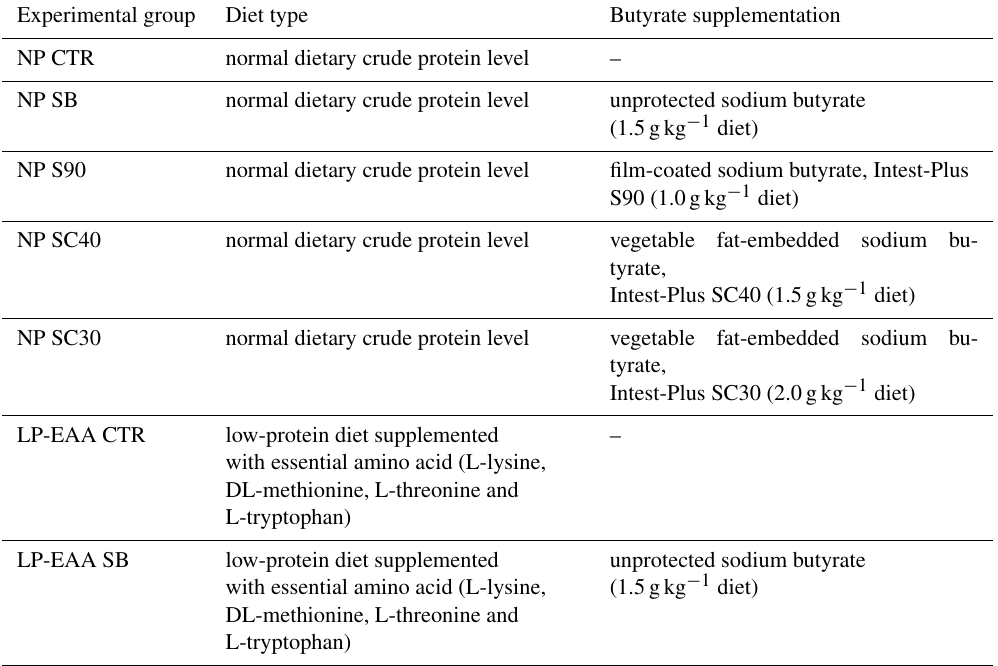
Table 1. Experimental groups of the